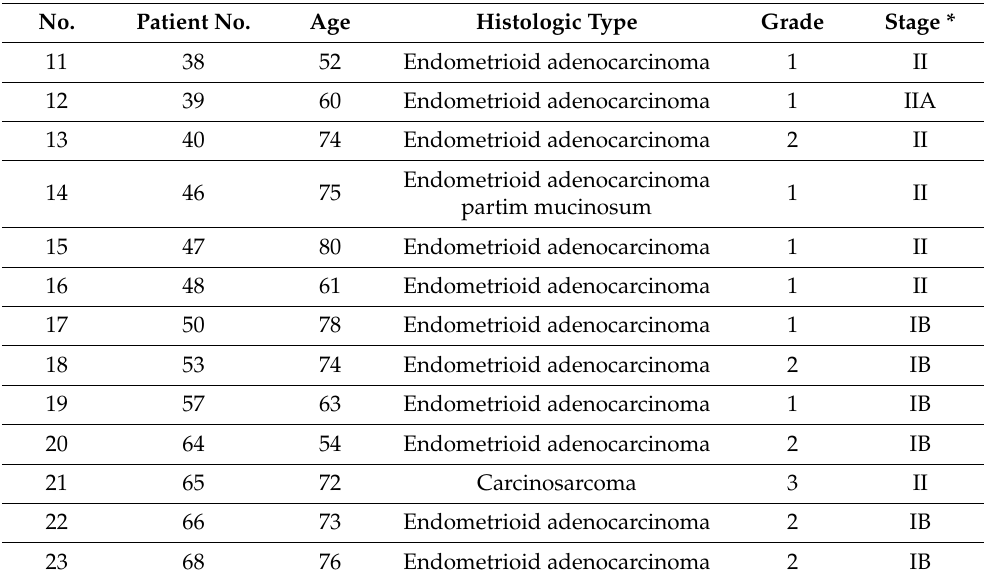
Table 1. Cont. Patients with Cancer Cell-Free Tumor-Adjacent Tissues (TA), n = 26 No. Patient No.